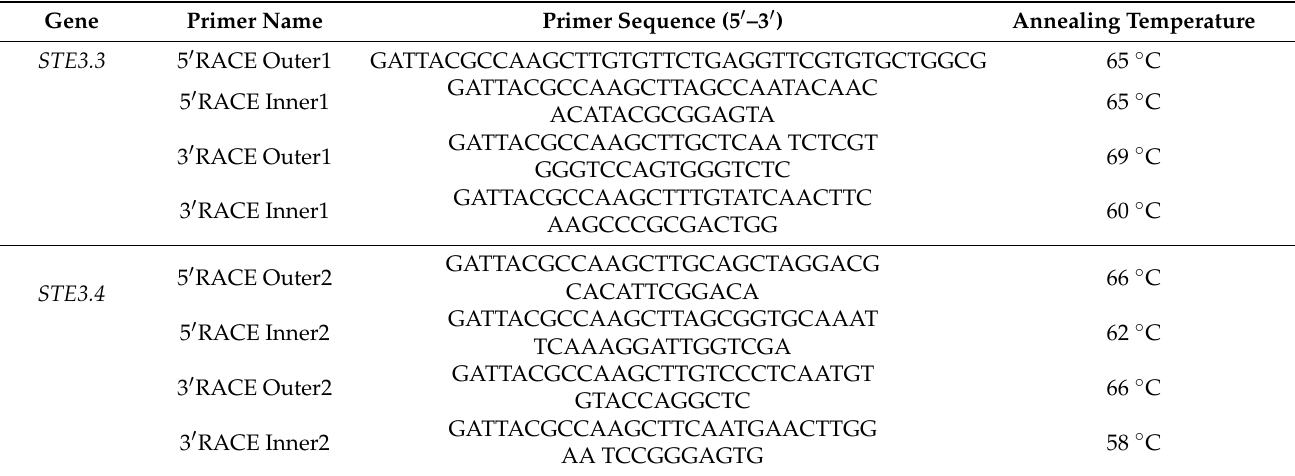
Table 2. Primer sequences for RACE amplification of STE3